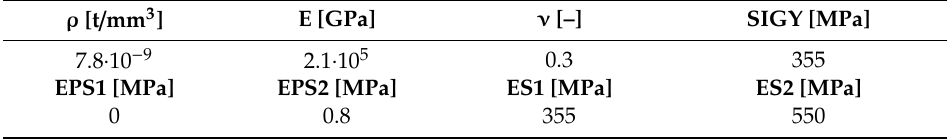
Table 3. Material properties for S355 steel for the MAT_PIECEWISE_LINEAR_PLASTICITY material